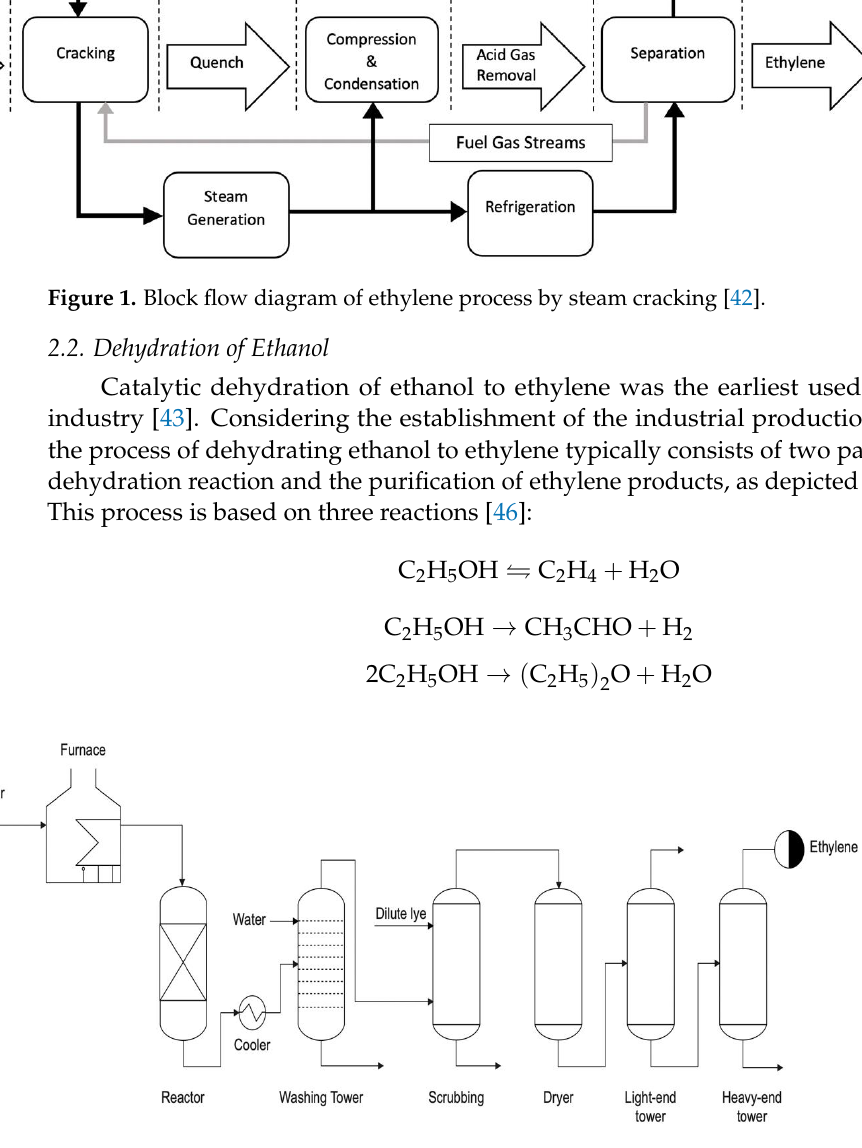
Figure 2. Process flow diagram of ethylene process by dehydration of ethanol [45] .